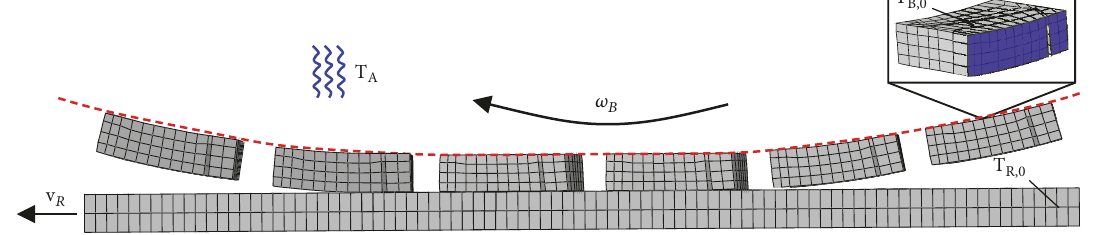
Figure 10: Rubber block moving on a tire-rotation-like displacement path.